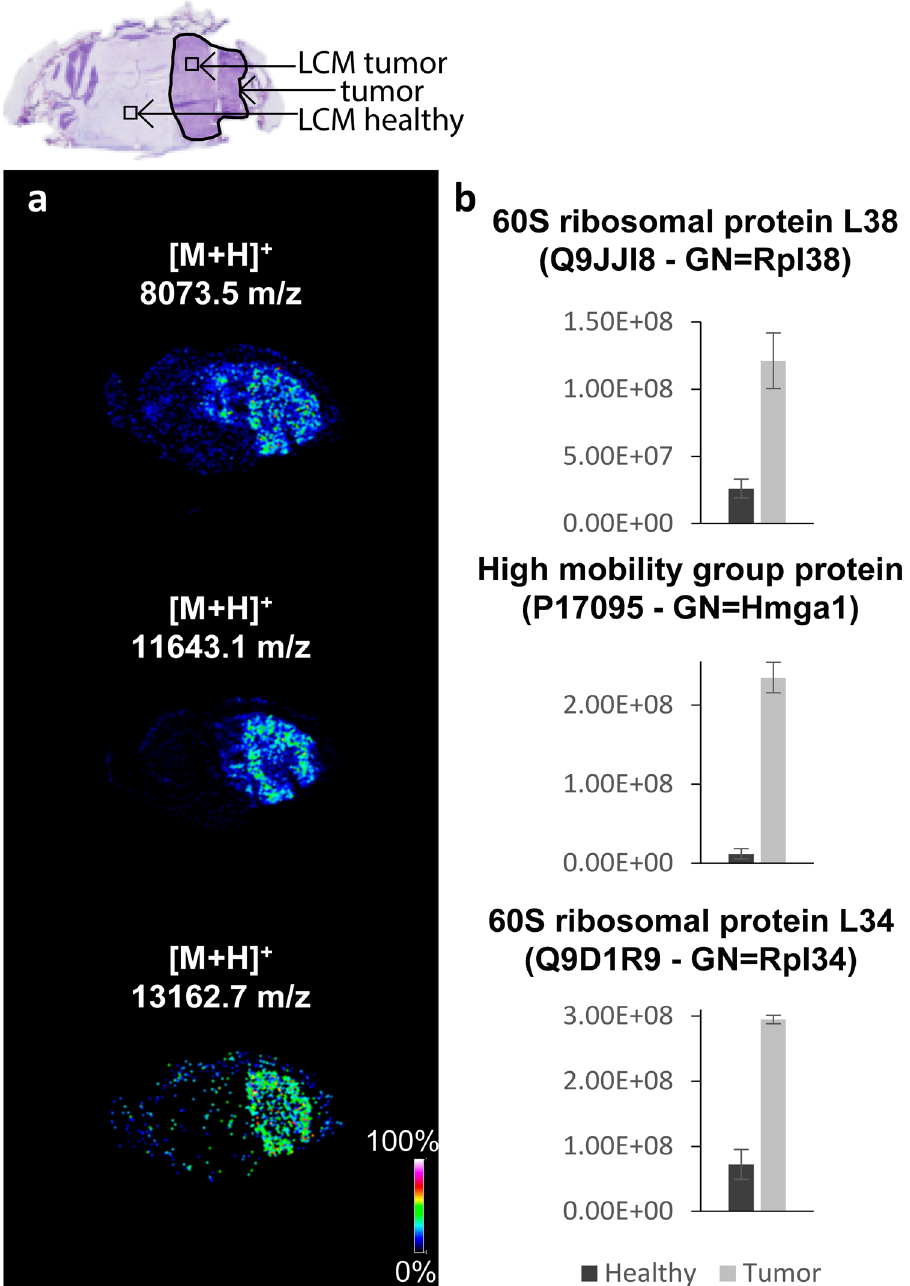
Figure 4. Comparison of LC-MS/MS and MALDI MSI data: the agreement between the fold-changes determined by LC-MS/MS of microdissected regions (microdissected regions are indicated in top histological image) and MSI datasets is demonstrated for three protein ions. In each case the LC-MS/MS relative quantification confirmed that observed with MALDI MSI. ( a ) Images extracted from the MSI dataset for 60 S ribosomal protein L38, High mobility group protein, 60 S ribosomal protein L34 (from the top). ( b ) LC-MS/ MS relative quantification: the bar charts report the sum of the areas of each protein’s tryptic peptides (data are mean area ± standard